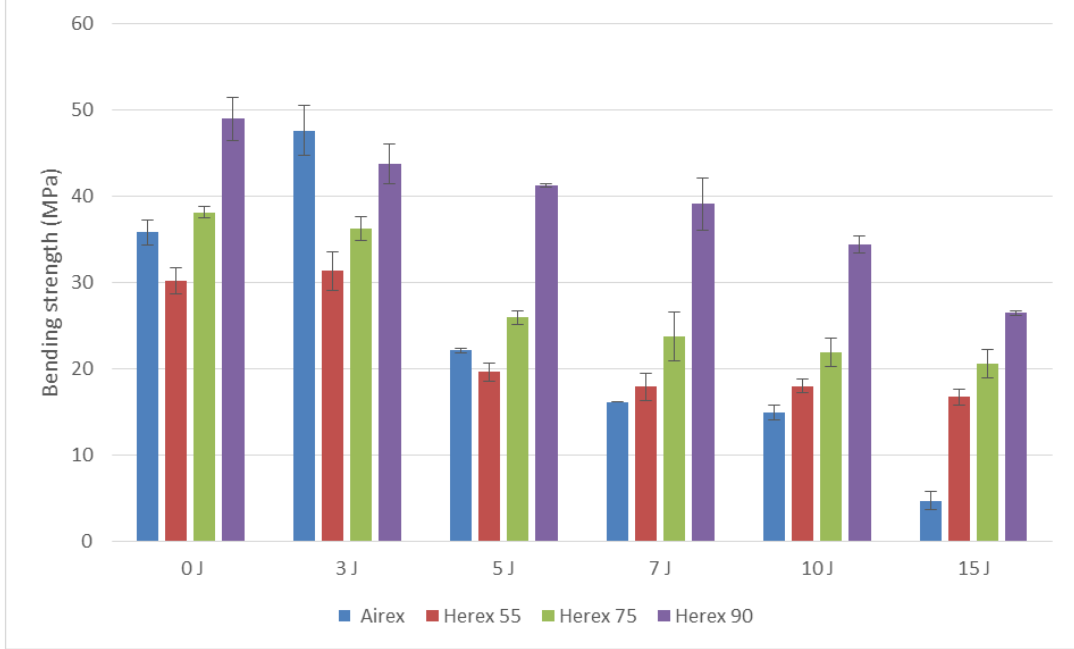
Figure 13. Bending strength of tested composites.